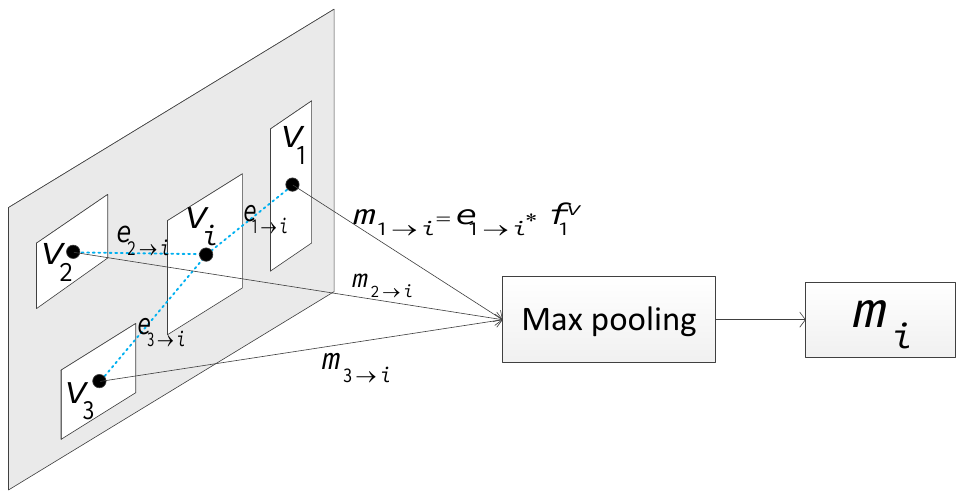
Figure 4. An illustration of building object-object relationship. The process is the same as [51]. For object v i , the message m 1 → i from object v 1 to object v i is controlled by e 1 → i